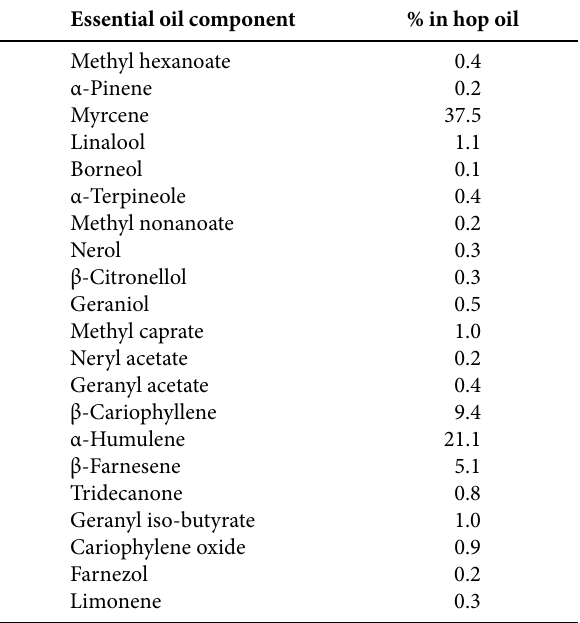
Table 1: Composition of Dana essential oil Essential oil component